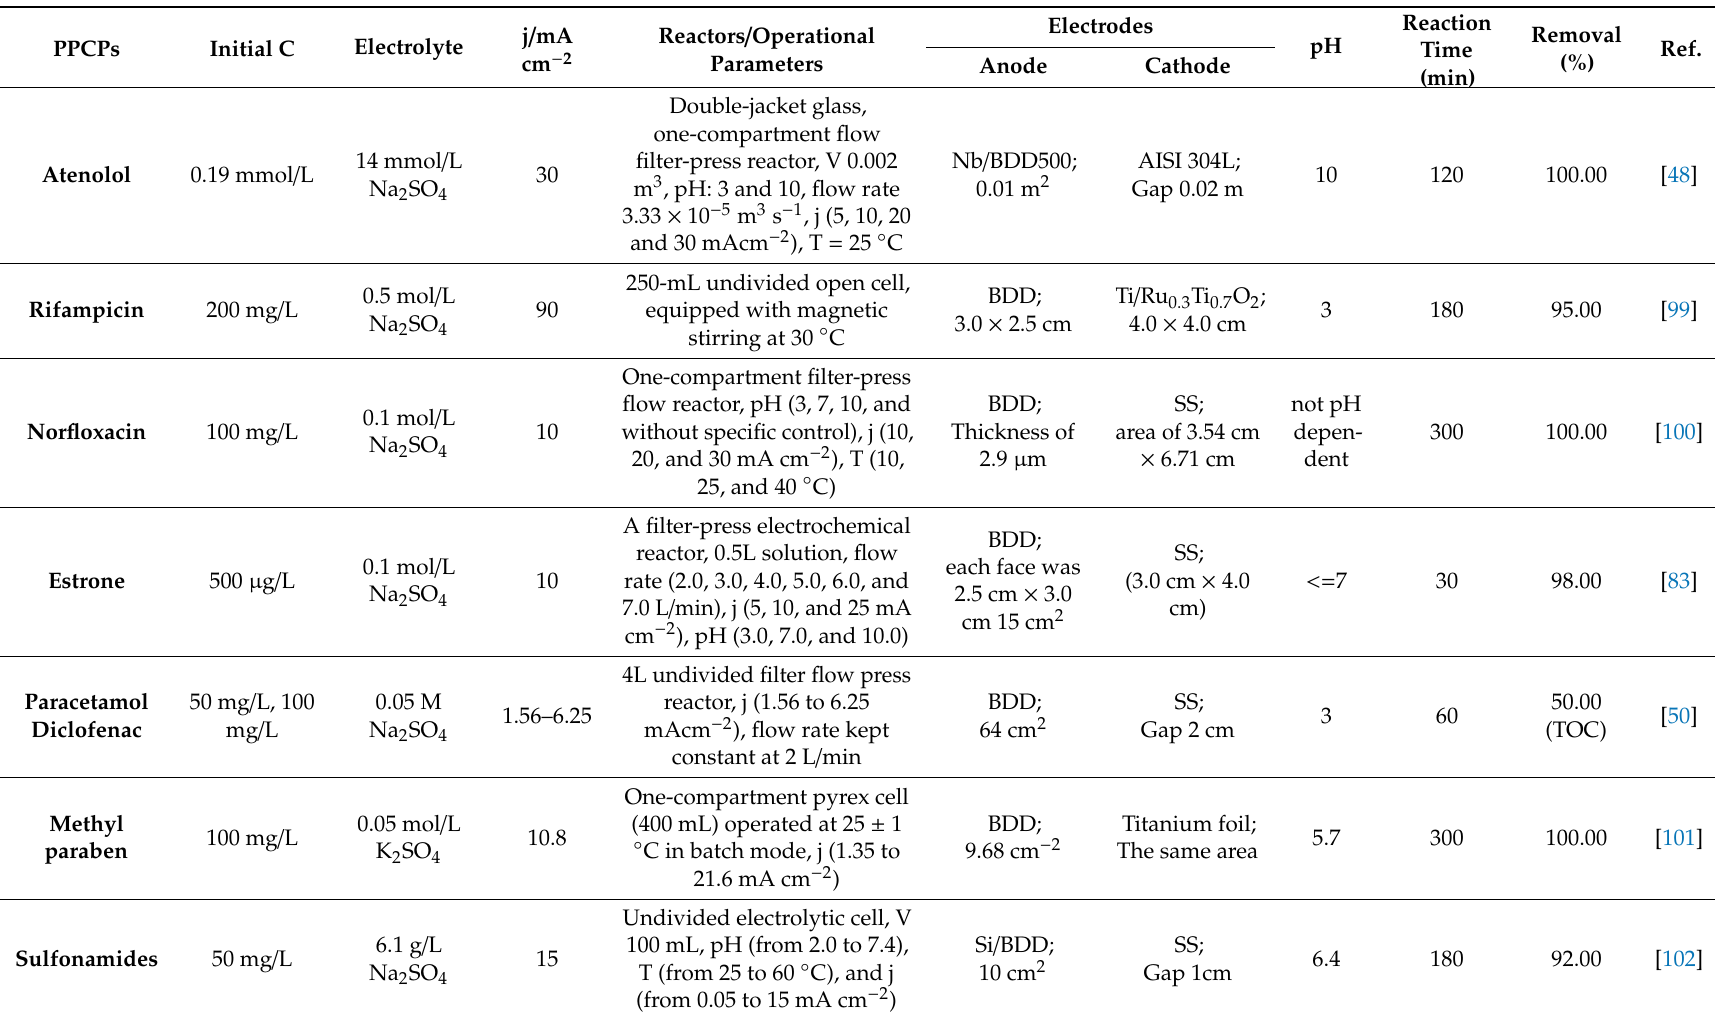
Table 6. Selected results reported for PPCPs removal by EOP with BDD